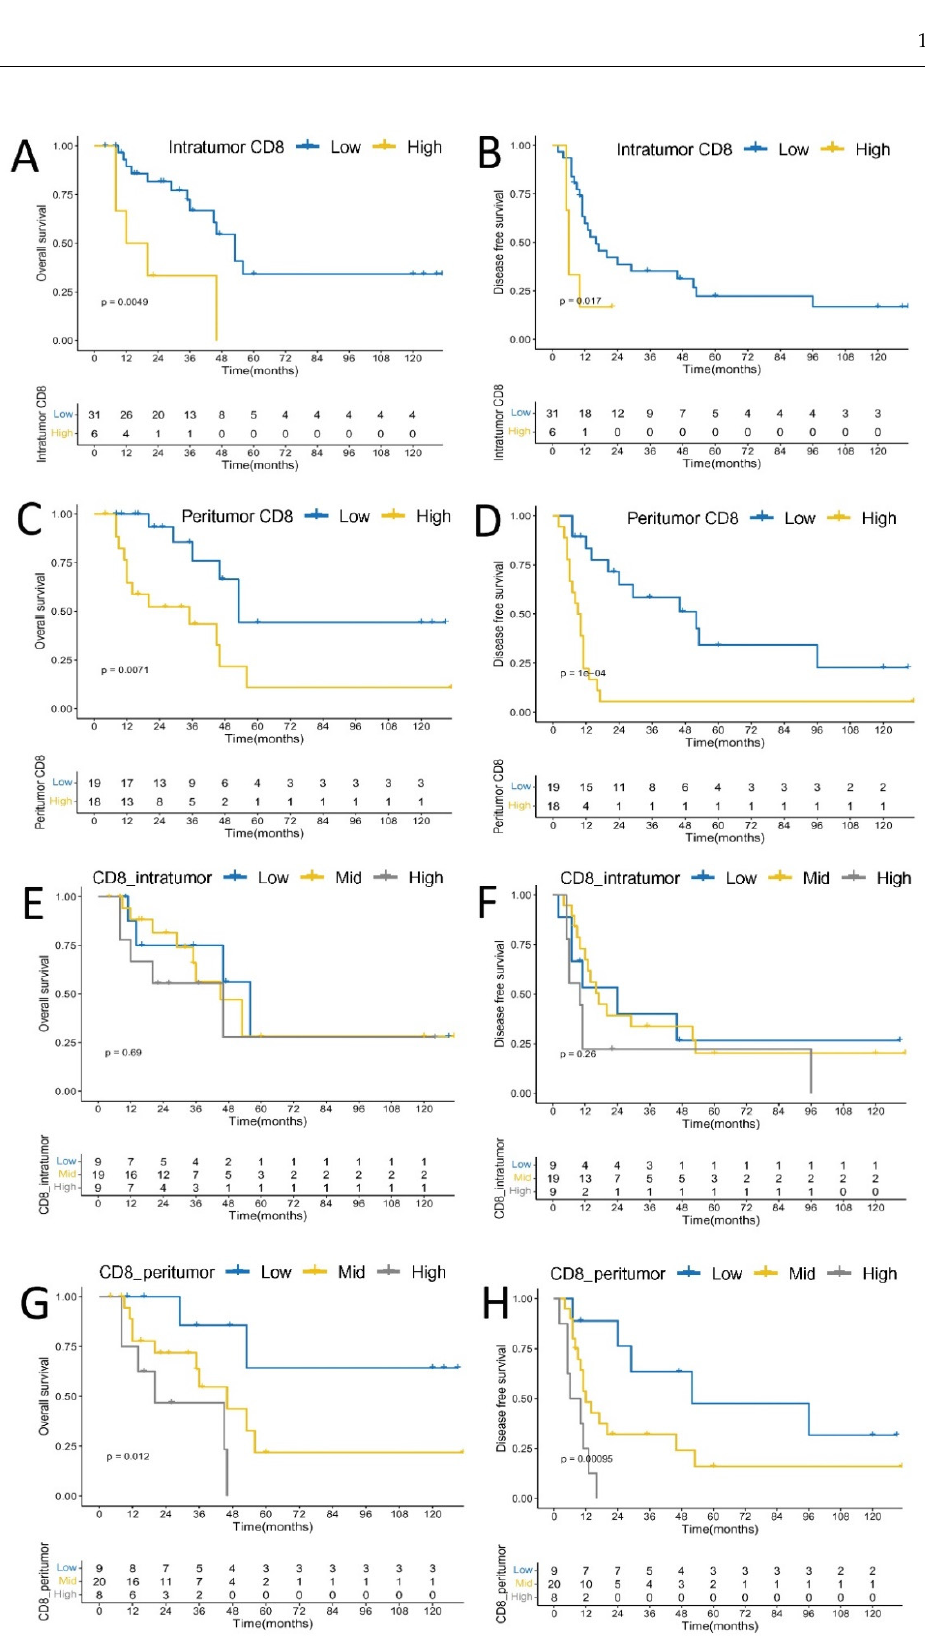
Figure 7. Kaplan–Meier analysis of CD8+ T cell density and overall survival. ( A ) Intratumoral CD8; ( C ) Peritumoral CD8; ( E ) Intratumoral CD8 as levels by quartiles; ( G ) Peritumoral CD8 as levels by quartiles; Kaplan–Meier analysis of CD8+ T cells density and disease free survival. ( B ) Intratumoral CD8; ( D ) Peritumoral CD8; ( F ) Intratumoral CD8 as levels by quartiles; ( H ) Peritumoral CD8 as levels by quartiles.